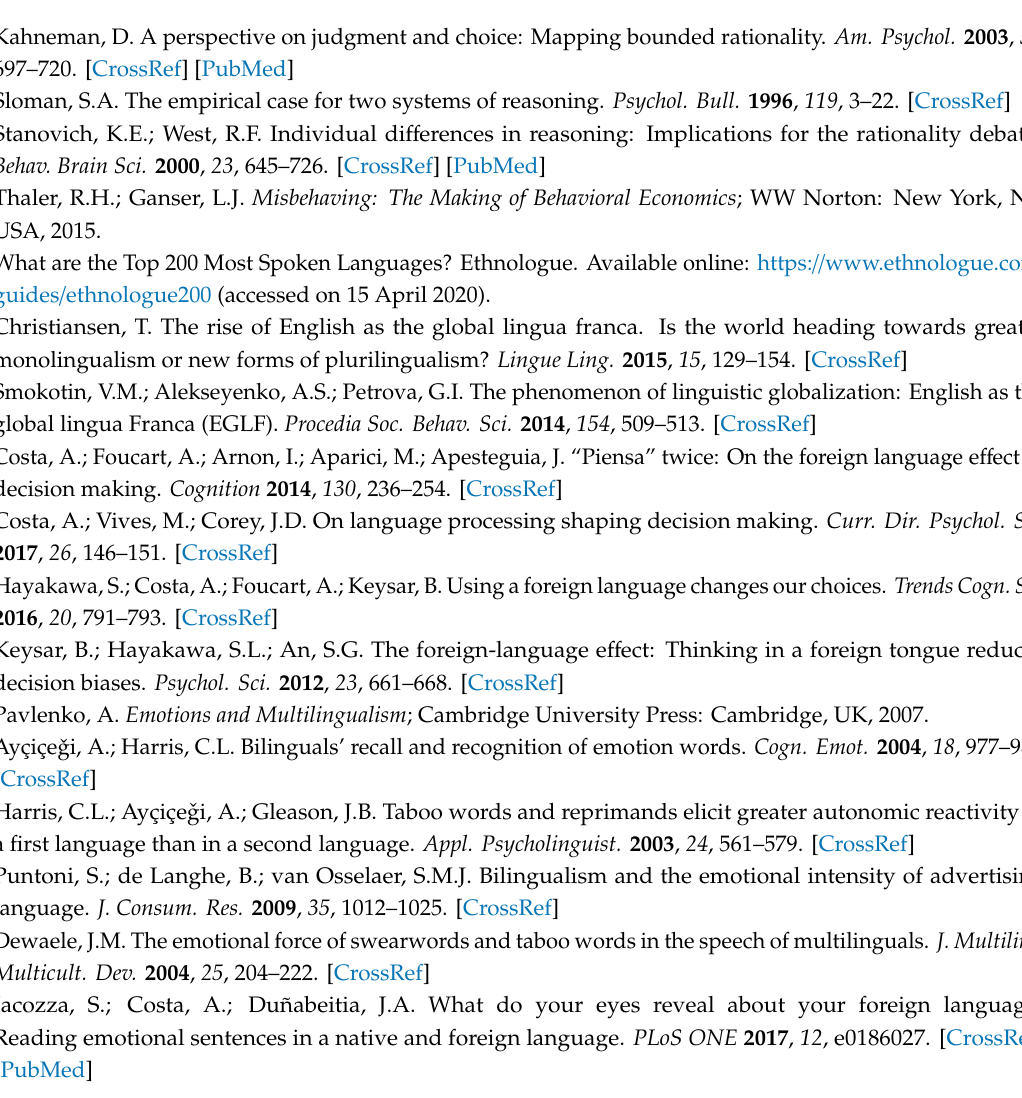
Table S1: Number of correctly deposited tokens for each participant in the Spanish and English groups for Days 1 and 2 separated by block colour. Five tokens of each colour had to be placed in the corresponding